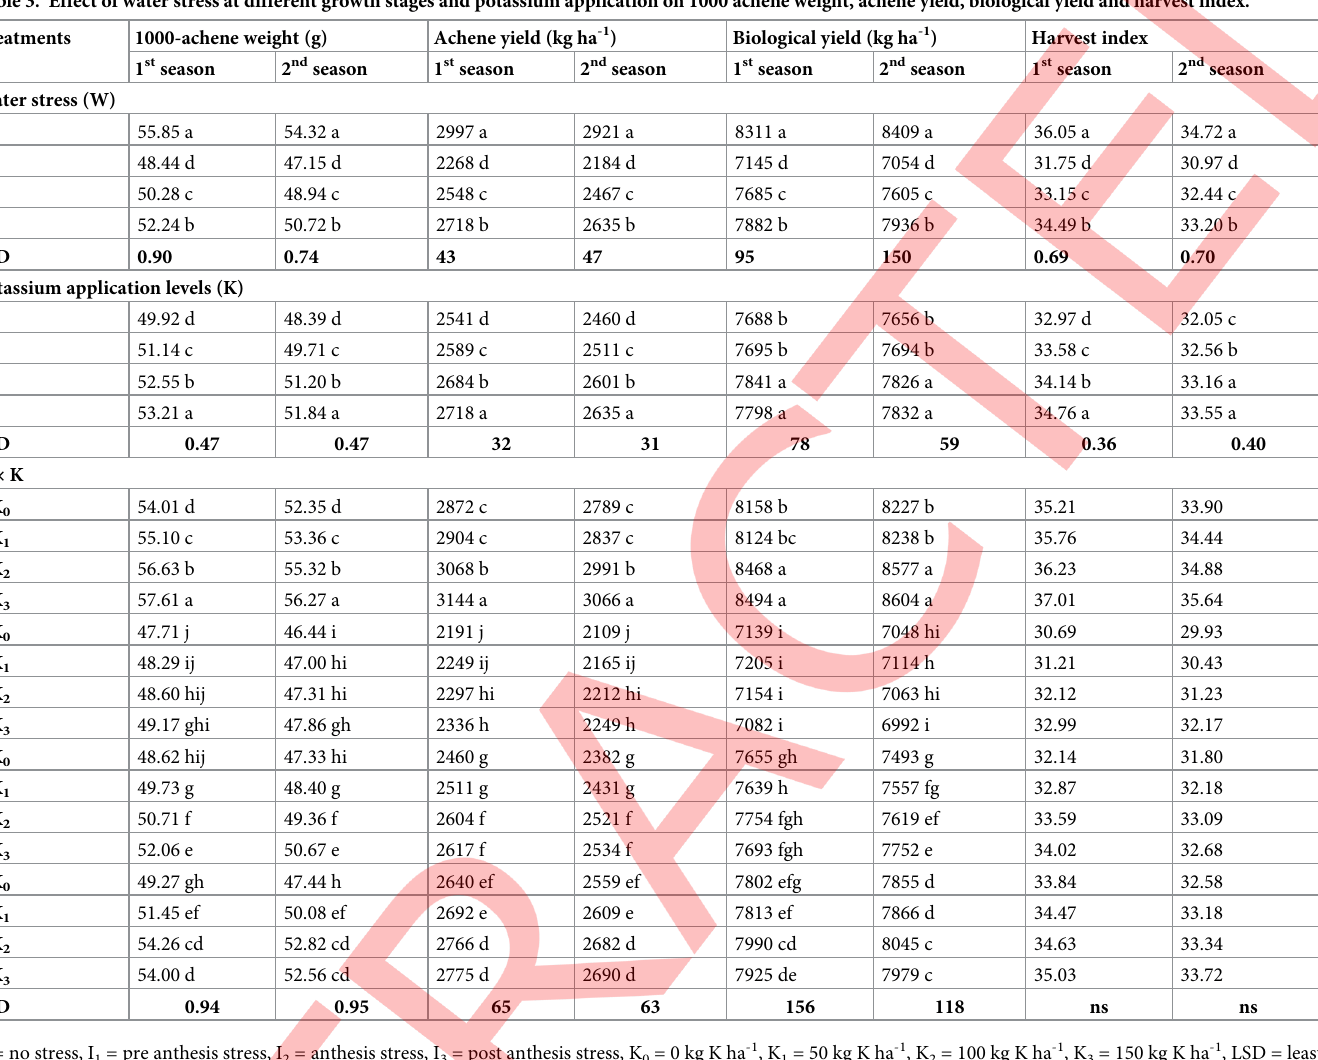
Table 3. Effect of water stress at different growth stages and potassium application on 1000 achene weight, achene yield, biological yield and harvest index. Treatments 1000-achene weight